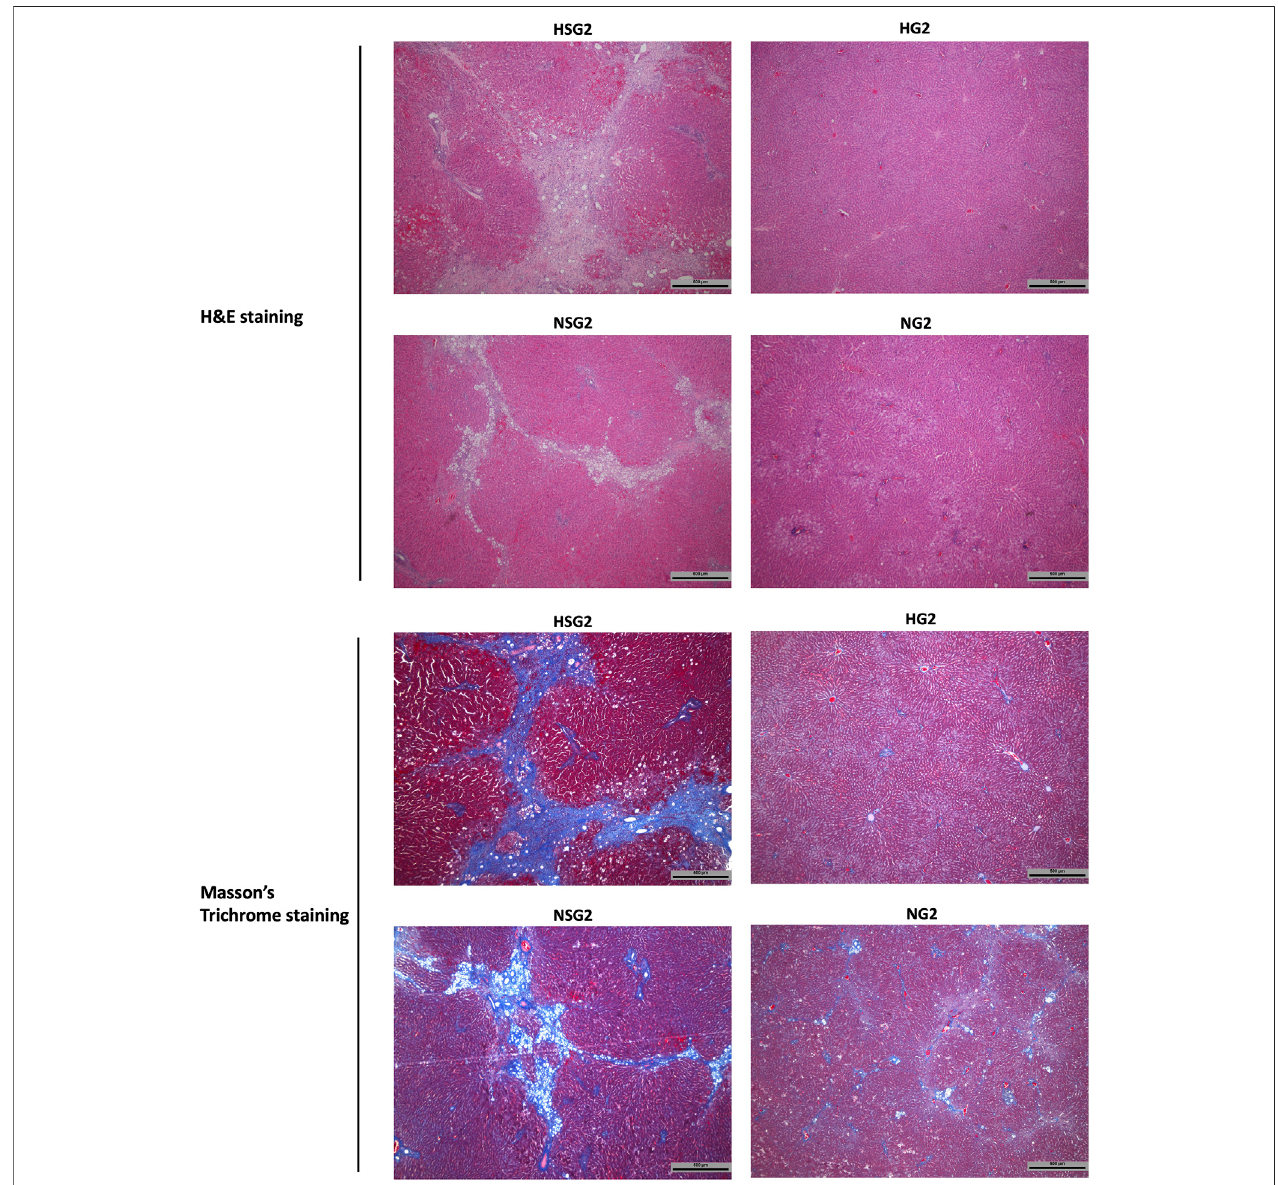
FIGURE 9 | Hepatic H&E and Masson ’ s trichrome staining of healthy and NASH rats which received two-week coadministration of SV and GJ (HSG2 and NSG2) and GJ (HG2 and NG2) at 90 days after discontinuation of herb/drug treatments. H and N denoted healthy and NASH, respectively. C, S, and G indicated that the rats received vehicle, SV, and GJ,